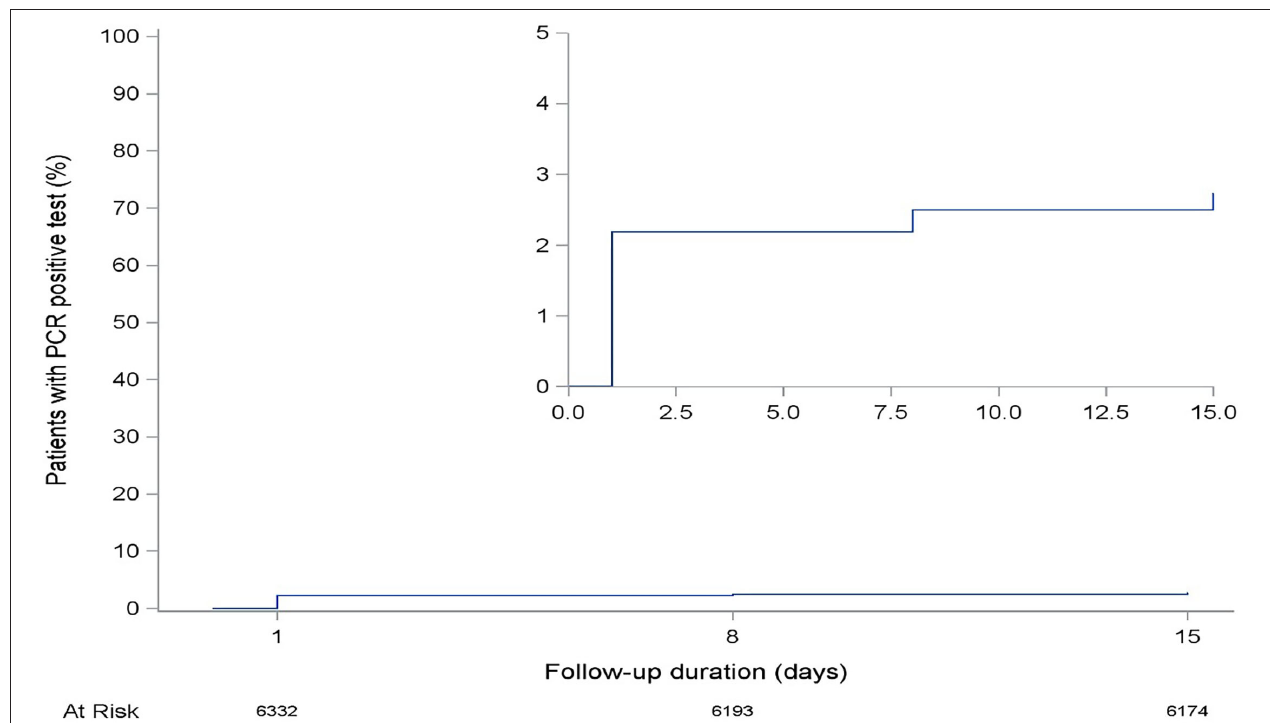
FIGURE 2 | The cumulative incidence rate of severe acute respiratory syndrome coronavirus 2 (SARS-CoV-2) test positivity among airport arrival passengers, April–August 2020, Burkina